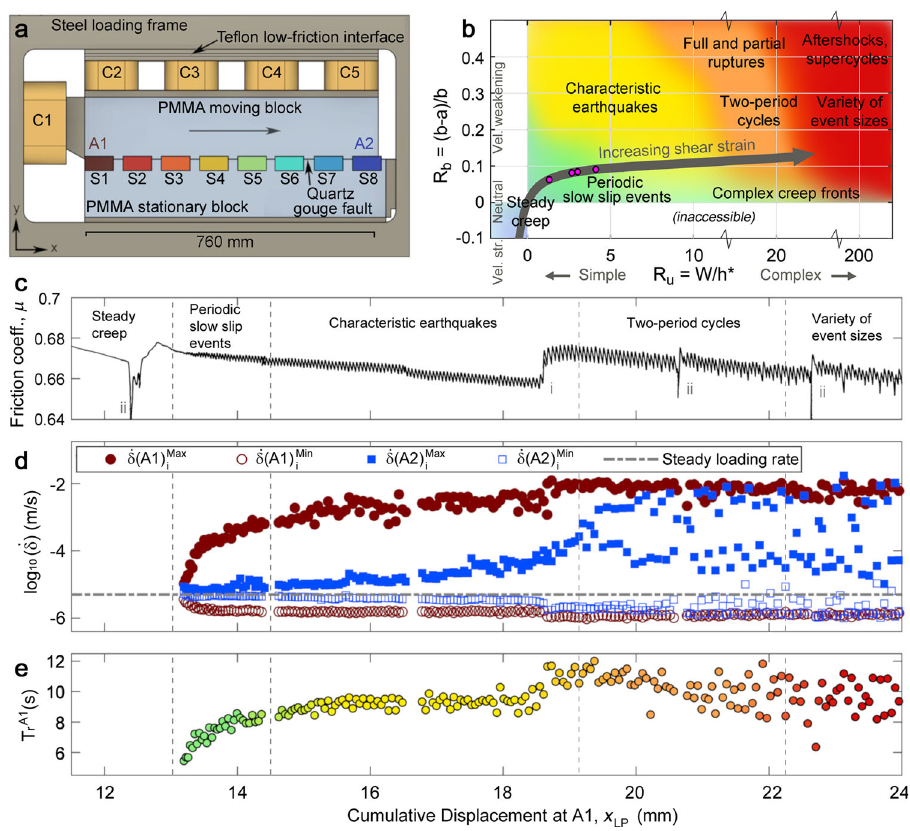
Fig. 1 | Experimental system and evolution of earthquake behavior. a Diagram of the sample loaded with hydraulic cylinders C1-C5. 8 slip sensors (S1-S8) are color-coded:forcingend(A1,red)toleadingend(A2,blue). b Inourexperiment, friction properties evolve with continued shear strain (Supplementary Table 1 and Supplementary Fig. 1) and chart a path (gray arrow) through R u – R b space that transitions from steady creep to more complicated behavior. Magenta